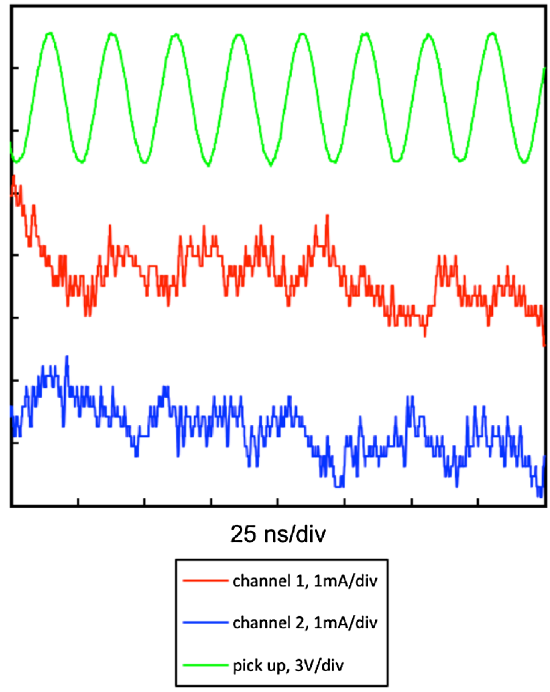
FIG. 34. Bunch structure of the acceleration beam (extraction voltage: 30 kV; plasma input position: 6